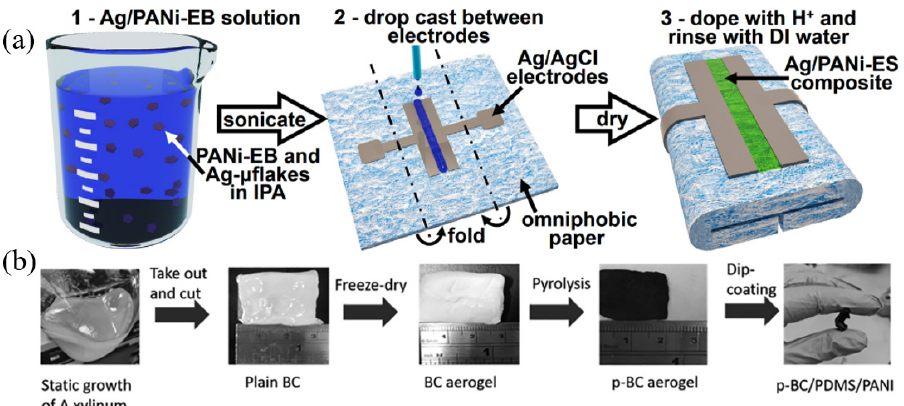
Figure 3. Modification of electrochemical sensors electrodes for pH detection in wounds. ( a ) Preparation process of Ag/PANI composite electrode [78]. Copyright (2018) Elsevier. ( b ) Fabrication process of p-BC/PDMS/PANI nanocomposite [112]. Copyright (2021) Elsevier.